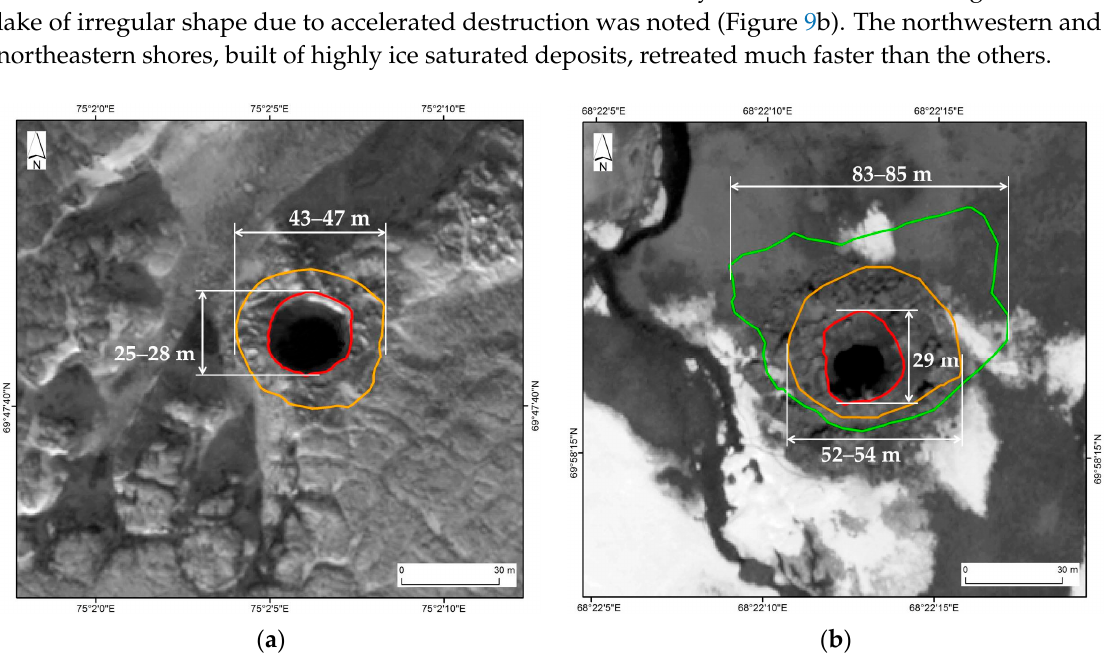
Figure 9. Crater evolution: ( a ) position of the upper edge of the AntGEC: red line as of 11 October 2014 (WorldView-1 image), orange line as of 31 August 2015 (Resurs-P2 image); ( b ) position of the GEC-1 upper edge: red line as of 15 June 2014 (WorldView-1 image), orange line as of 31 August 2015 (according to the field survey), green line as of 19 October 2016 (according to the field survey).